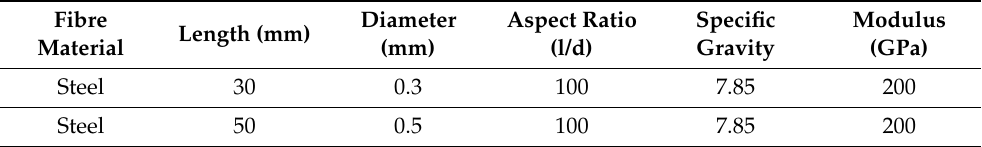
Table 1. Properties of steel fibres.